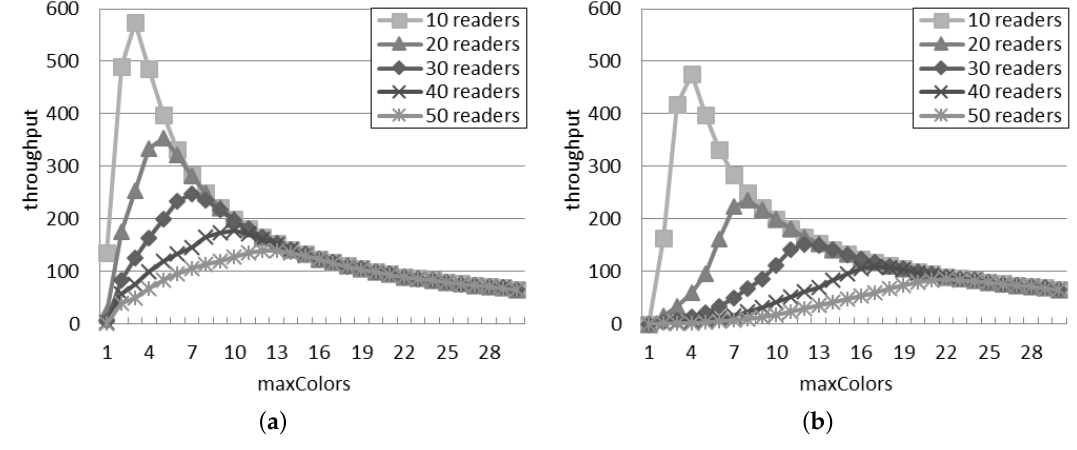
Figure 10. Throughput in the DCS scenario. ( a ) Single interference model; ( b ) Additive interference